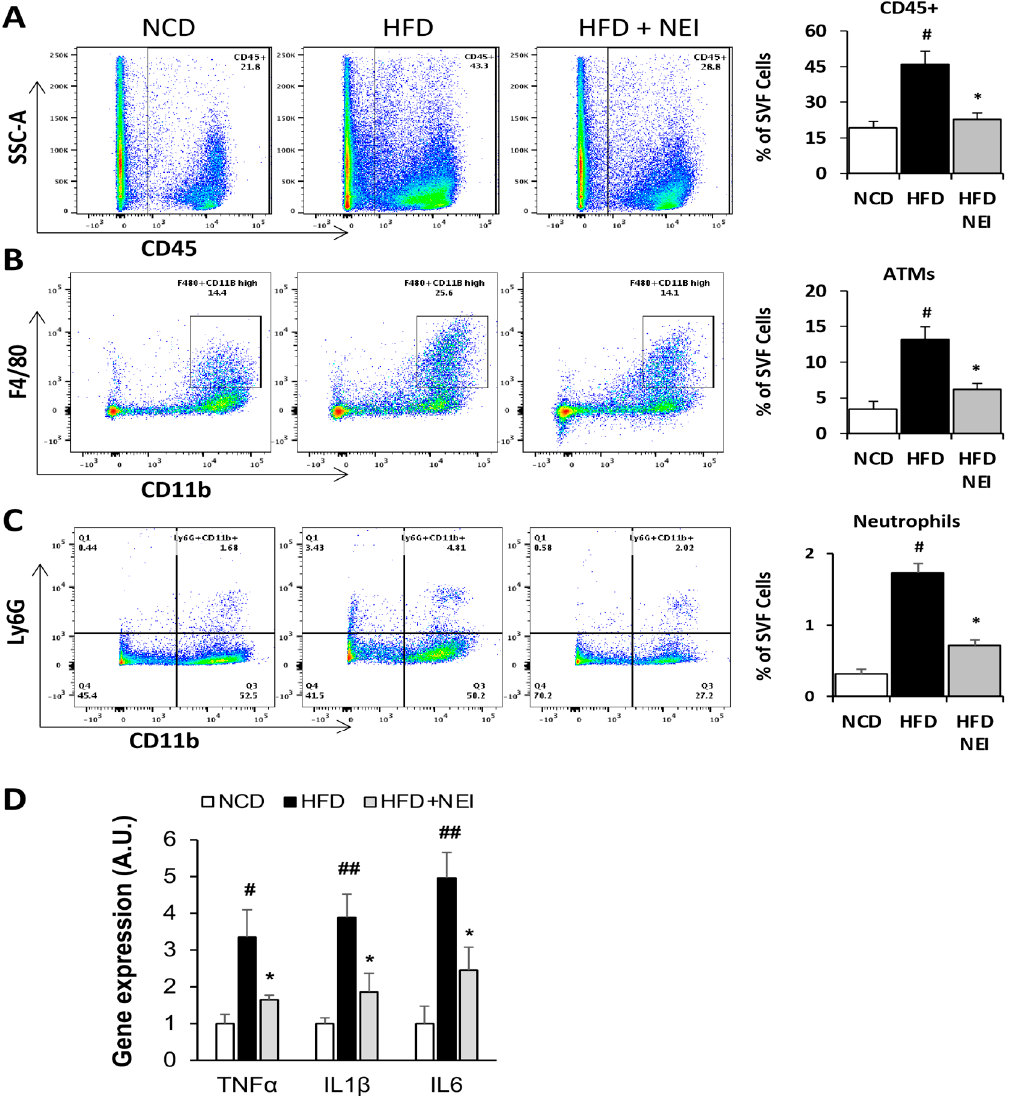
Figure 7. Inhibition of NE attenuated HFD feeding-induced leukocyte infiltration and pro- inflammatory cytokine expression in WAT. C57BL/6 mice (8-week-old males) were fed with ei- ther a standard chow diet, an HFD (60% kcal of fat), or HFD plus NEI (GW311616A, 25 mg/kg HFD) for 14 weeks before being perfused with PBS to remove blood cells in the circulation. SVF cells were isolated from eWAT for flow cytometry analyses of total CD45 + immune cells ( A ), CD45 + CD11b high F4/80 + adipose tissue macrophages (ATMs) ( B ), and CD45 + CD11b + Ly6G + neu- trophils ( C ). Total RNA samples from eWAT were used for RT-PCR to quantify mRNA expression levels of IL-1 β , TNF α , and IL6 ( D ). The expression levels were normalized against the 36B4 reference gene. All the values are expressed as mean ± SD, n = 5 or 6 in each group of mice. # p < 0.05, ## p < 0.01, chow versus HFD; * p < 0.05, HFD vs. HFD plus NEI. See also Figure